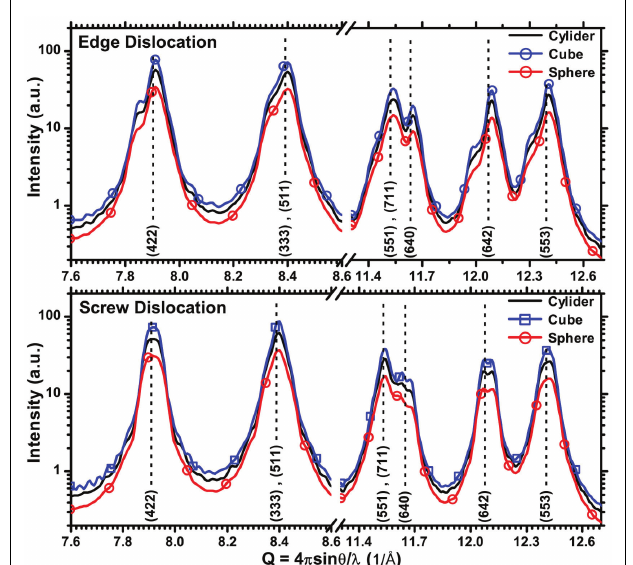
FIGURE 9 | X-ray powder diffraction patterns simulated by DSE from theTAM of cylindrical Pd nanocrystals with screw dislocation lines, and different height H (upper plot) or diameter D (lower plot)